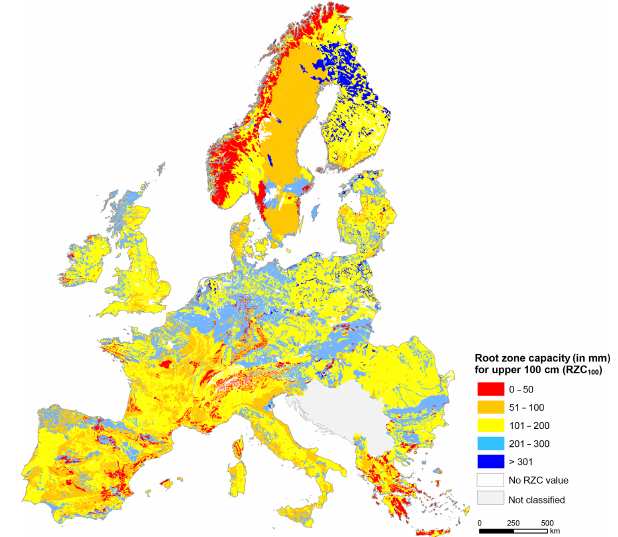
Figure 3. The soil organic carbon stocks (tha − 1 ) in Europe within the upper 100cm of soil calculated based on level-1 data (dominat- ing soil types